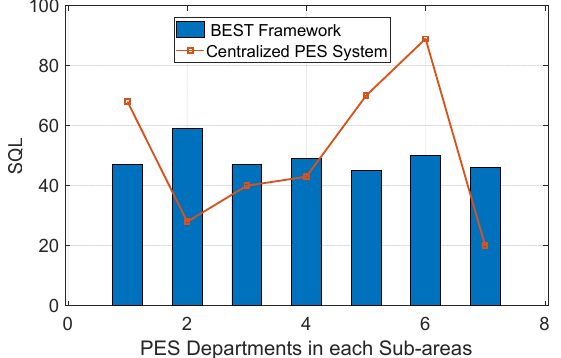
Figure 9. Comparison between the BEST framework and centralised PES system for SQL.